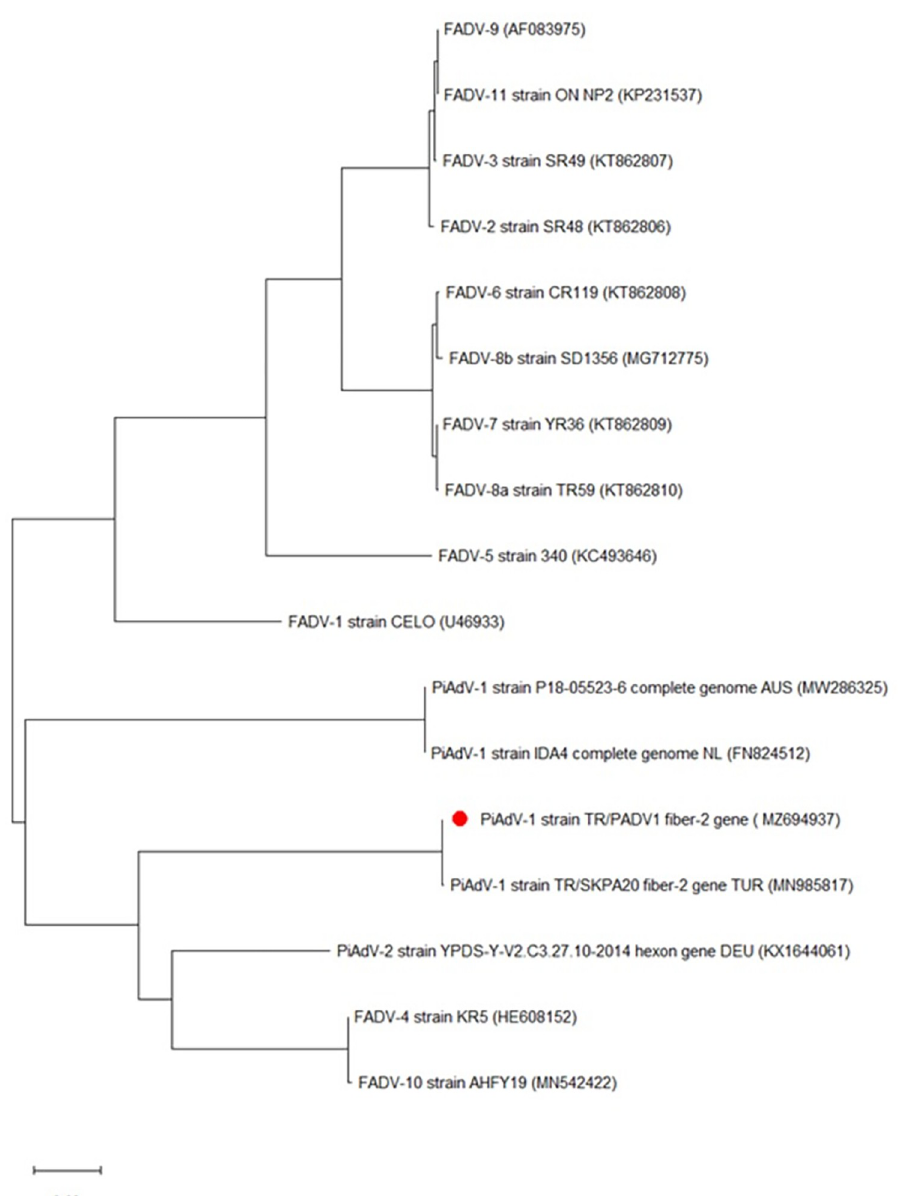
Fig 2. Phylogenetic tree based on the partial nucleotide sequence of the PiAdV-1 fiber-2 gene (967 bp). The tree shows adenovirus species which affect fowl. The tree shows the names and GenBank accession numbers of each isolate. The PiAdV isolate from this study is indicated by a red